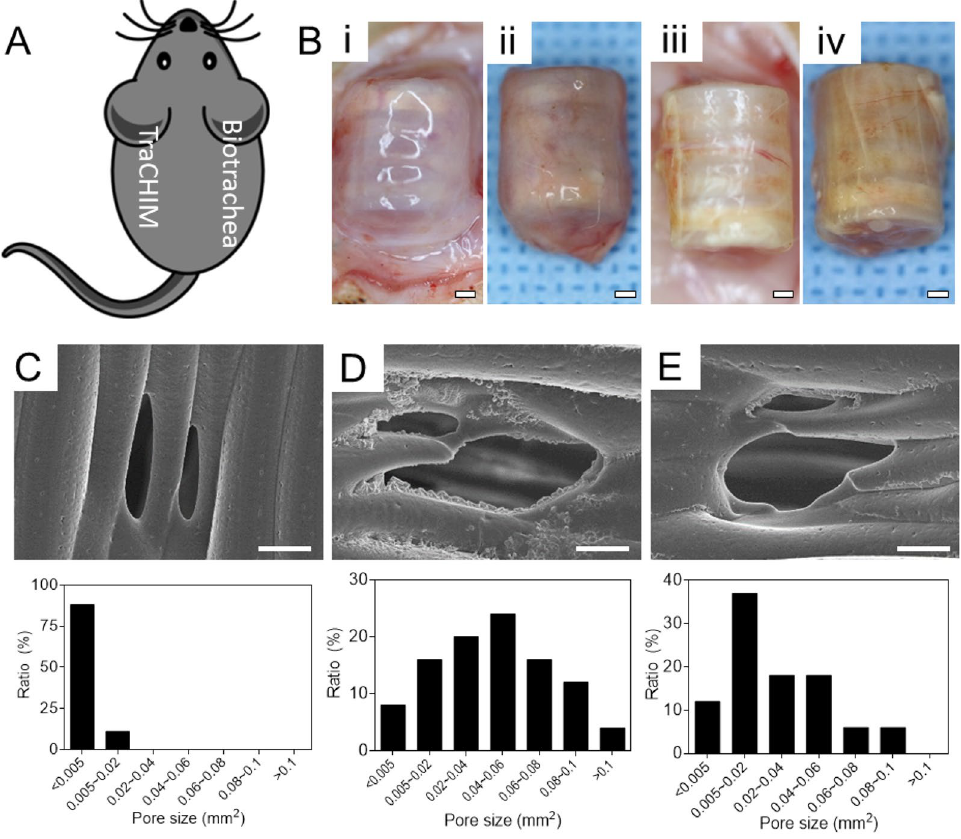
Figure 3. In vivo assessment: ( A ) Dorsal implantation site in rats. ( B ) Images of the harvested samples in post- operative 2 weeks: Biotrachea (i) in vivo and (ii) post-harvest; TraCHIM (iii) in vivo and (iv) post-harvest. Scale bars, 1 mm. SEM images (× 200) and pore distributions of post-harvest biotracheal PCL frames: ( C ) Original PCL frames; ( D ) Biotrachea-only group; and ( E ) TraCHIM group. Scale bars, 100 μm.